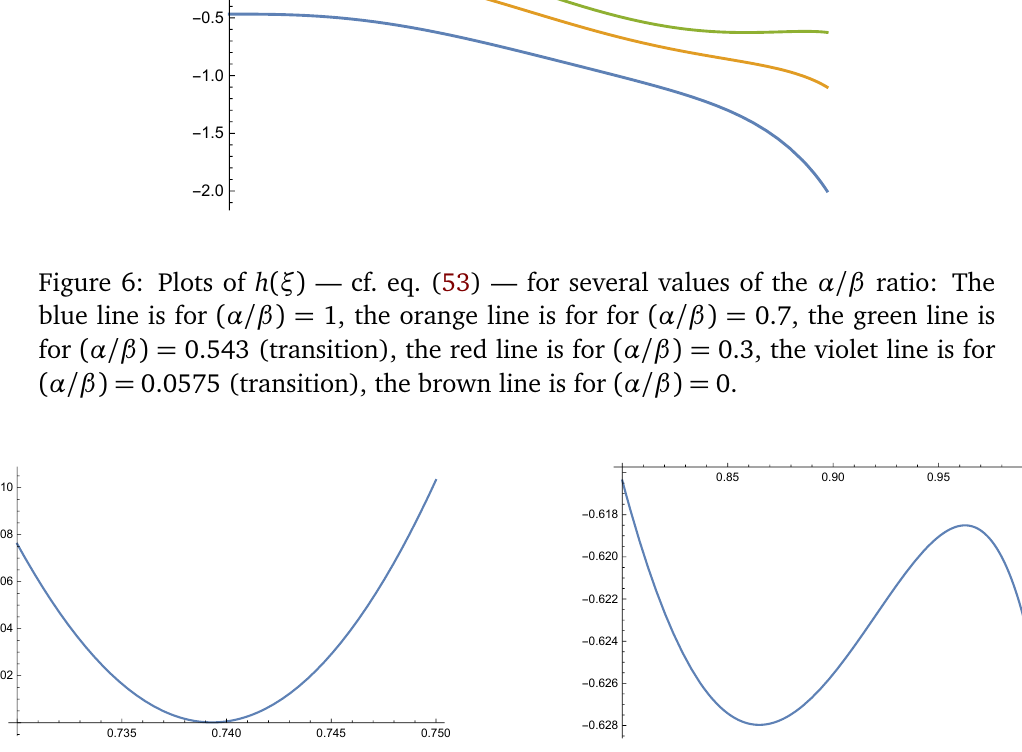
Figure 7: Zoomed-up plots of h ( ξ ) at critical values α/β ratio. The left plot is for ( α/β ) = 0.0575 and the right plot is for ( α/β ) =